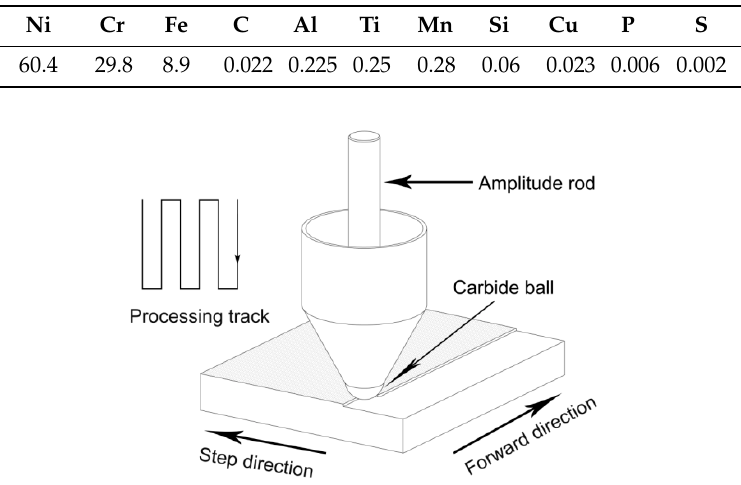
Table 1. Chemical composition of alloy 690.